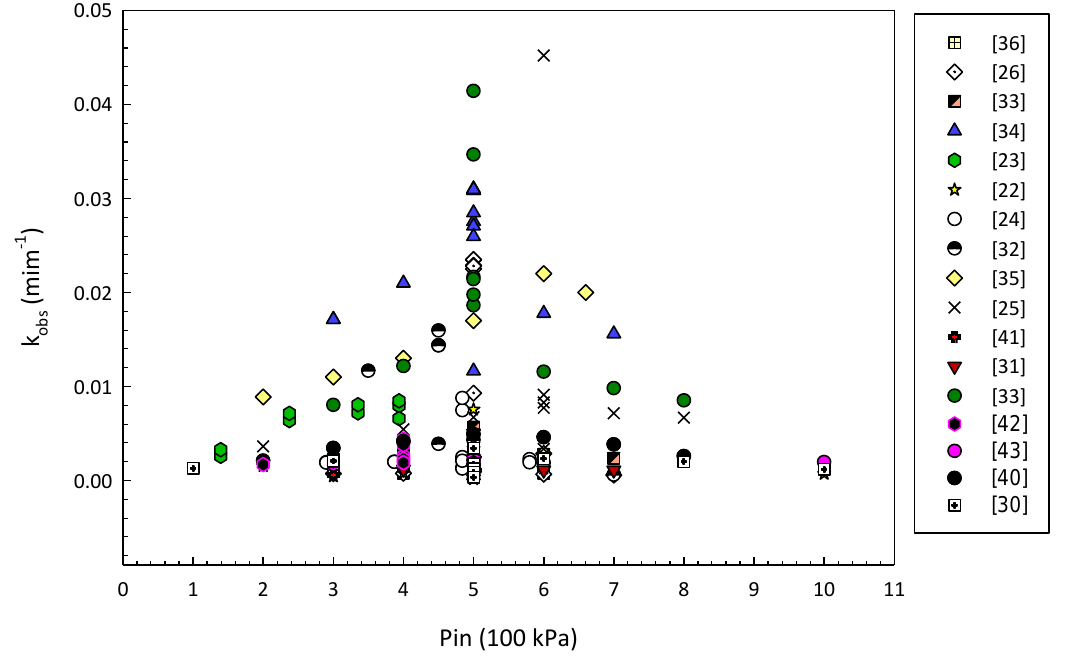
Figure 5. k obs vs. inlet pressure from the experimental works of Table 1.